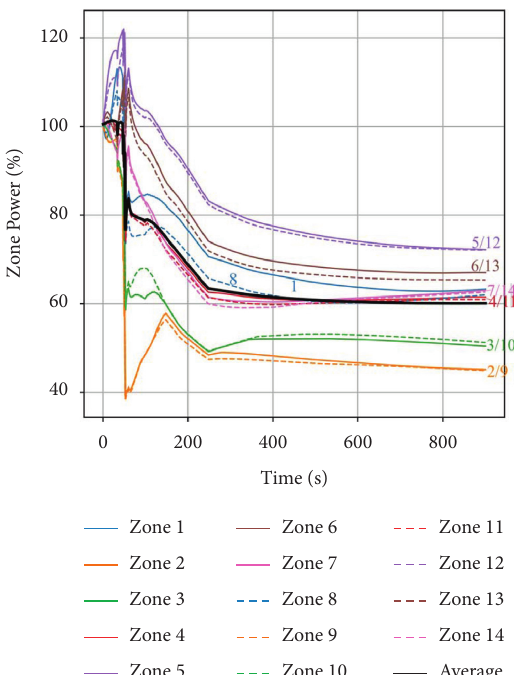
Figure 20: Zone powers for adjuster rod failure